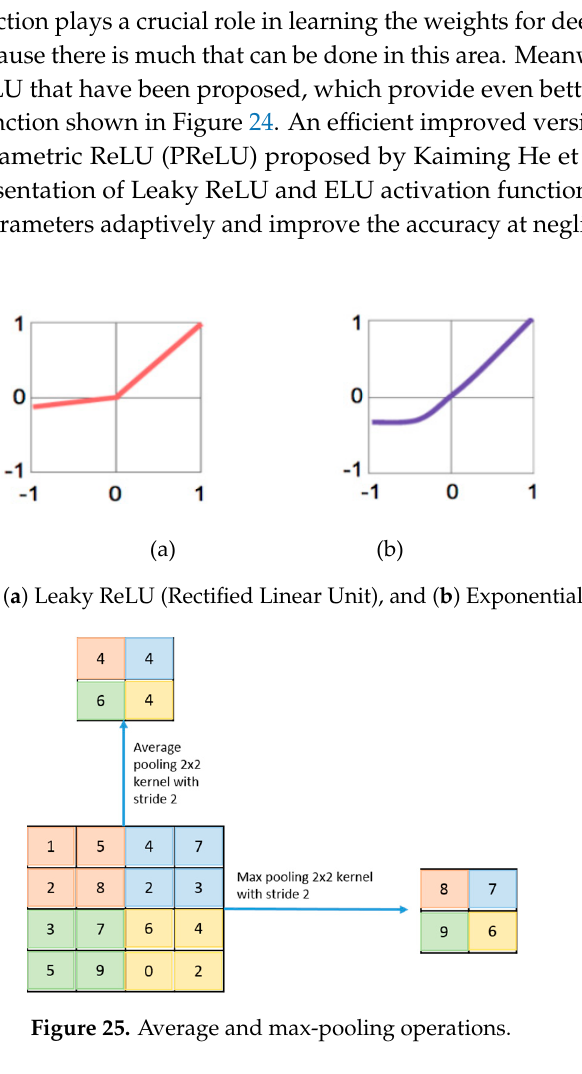
Figure 23. Pictorial representation of Rectified Linear Unit (ReLU).